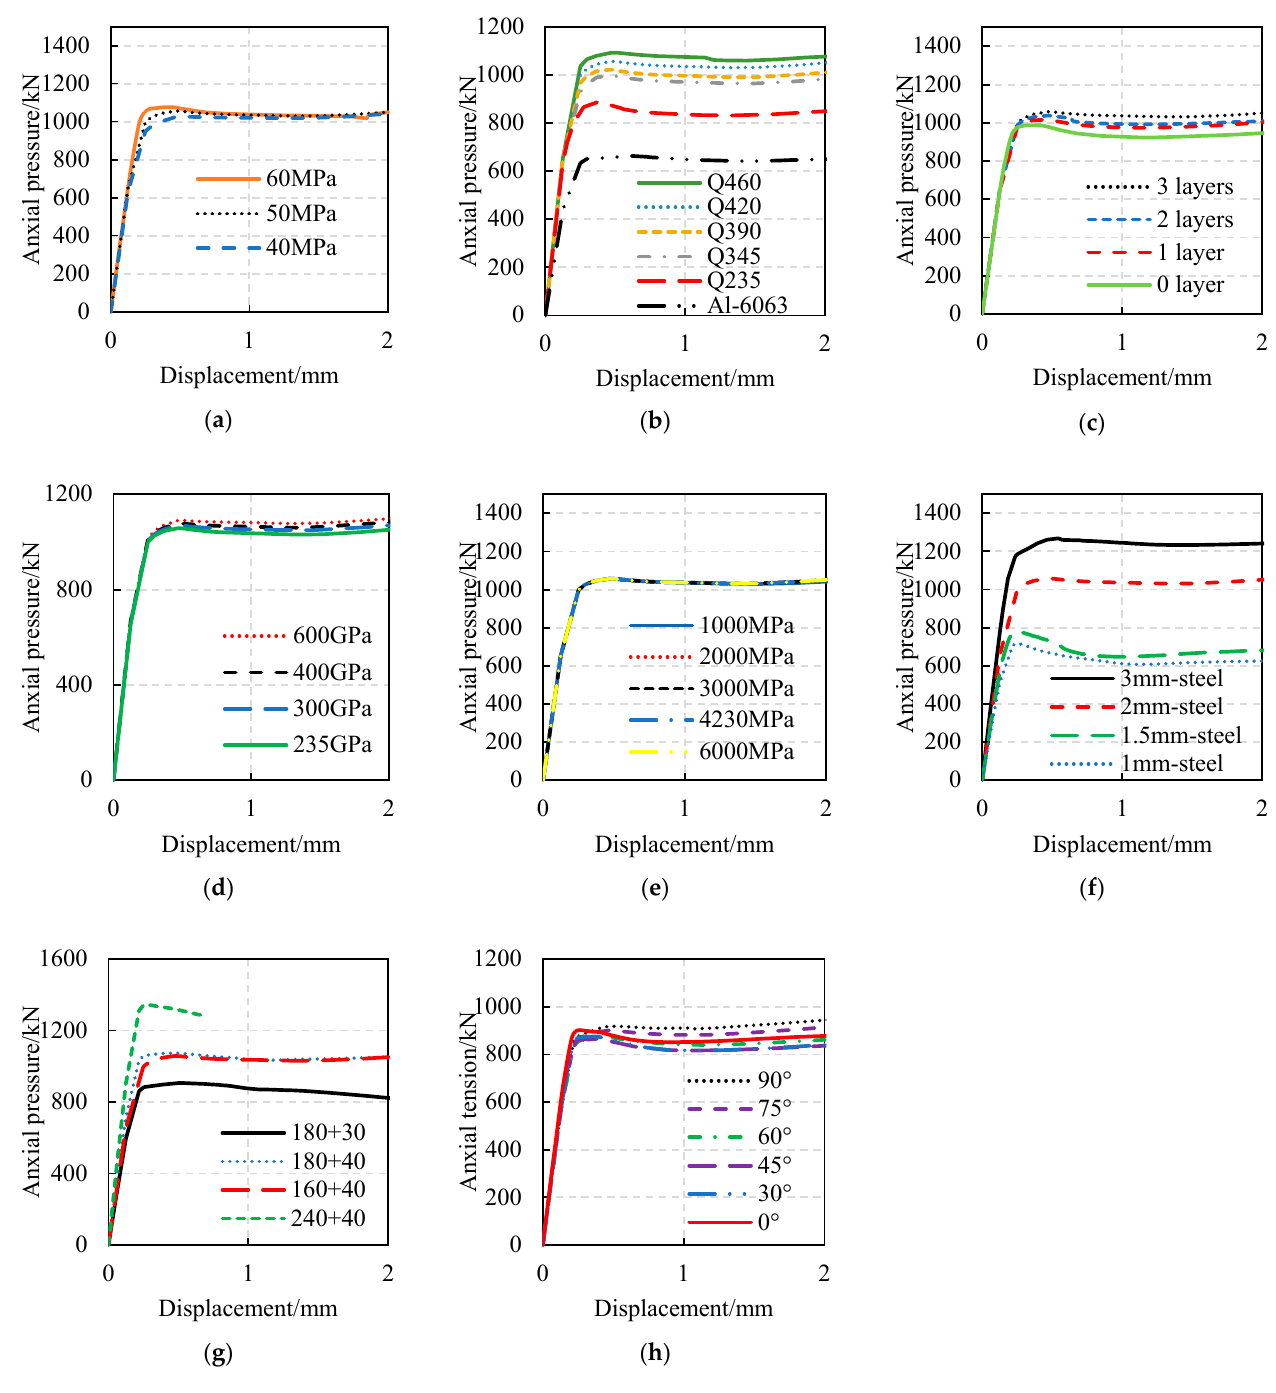
Figure 9. Parameter analysis of compression tests: ( a ) Variable is concrete strength. ( b ) Variable is steel grade. ( c ) Variable is the number of 0° CFRP layers. ( d ) Variable is the elastic modulus of CFRP. ( e ) Variable is the ultimate tensile strength of CFRP. ( f ) Variable is the thickness of the steel tubes. ( g ) Variable is the section size of the FWP. ( h ) Variable is the angle of the CFRP.